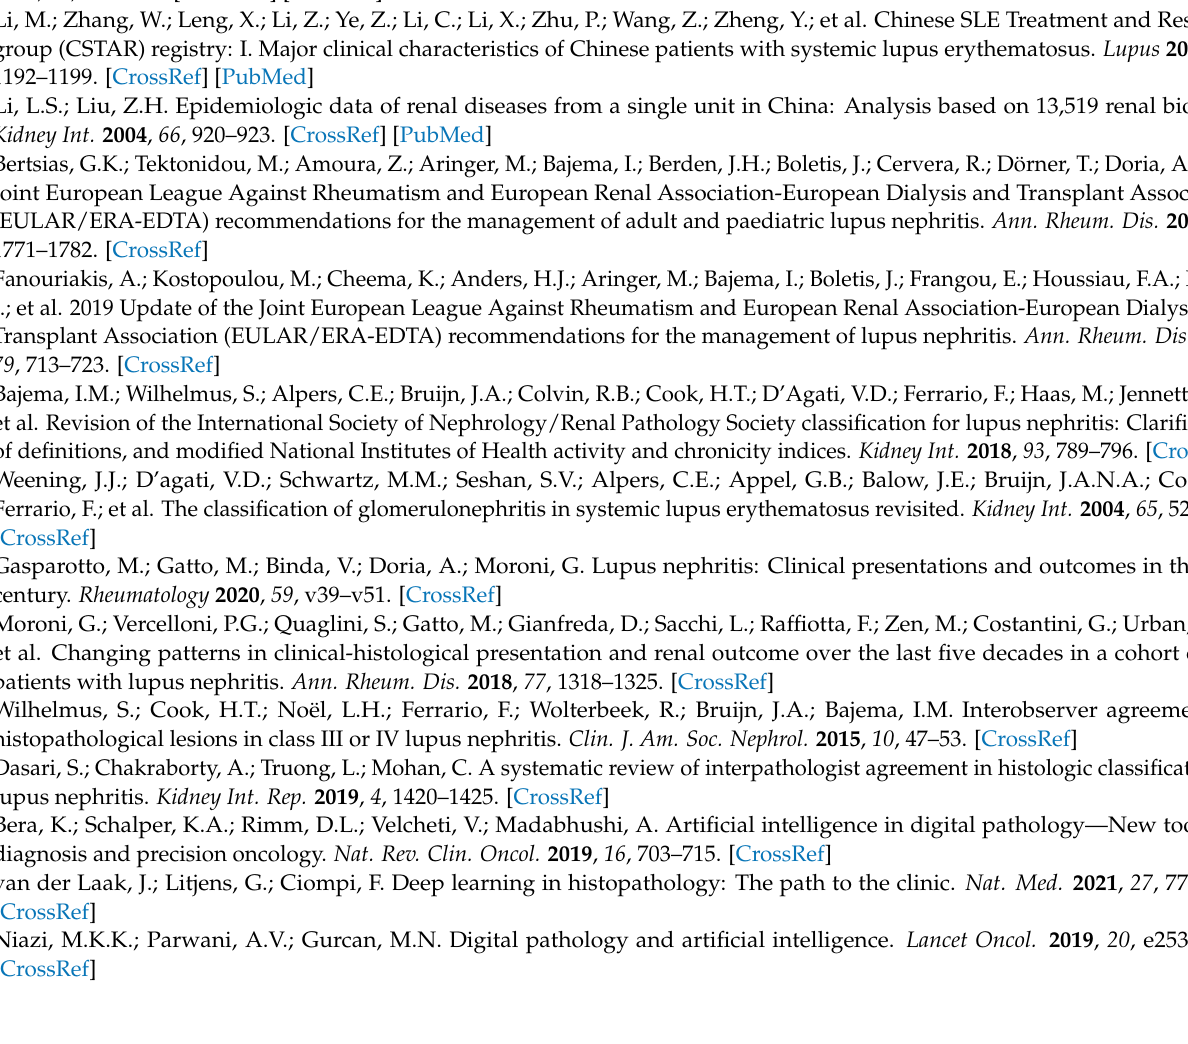
VGG16, Table S1: Clinicopathological features of lupus nephritis patients at time of